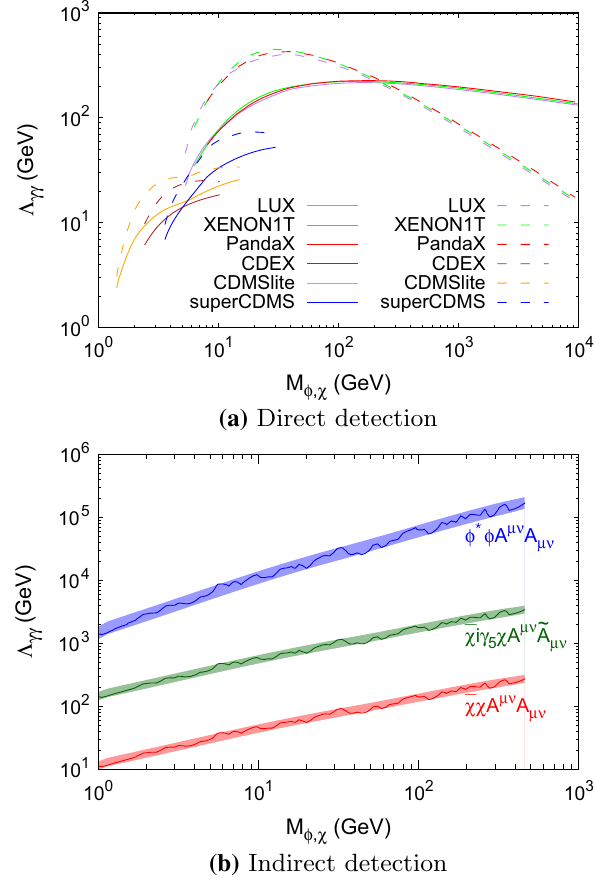
Fig. 6 Limit on Λ γγ for m φ,χ from direct (top) and indirect (bottom) detection searches. Direct detection includes latest results from Super- CDMS [47], CDEX [48], CDMSlite [49], XENON1T [50], LUX [51] and PandaX [52] experiments. Here solid(dashed) line denotes fermion with scalar type (scalar) DM for direct detection. Indirect detection uses the Fermi-LAT’s monochromatic photon constraint from R3 at 95% C.L. [53] observation region. a Direct detection. b Indirect